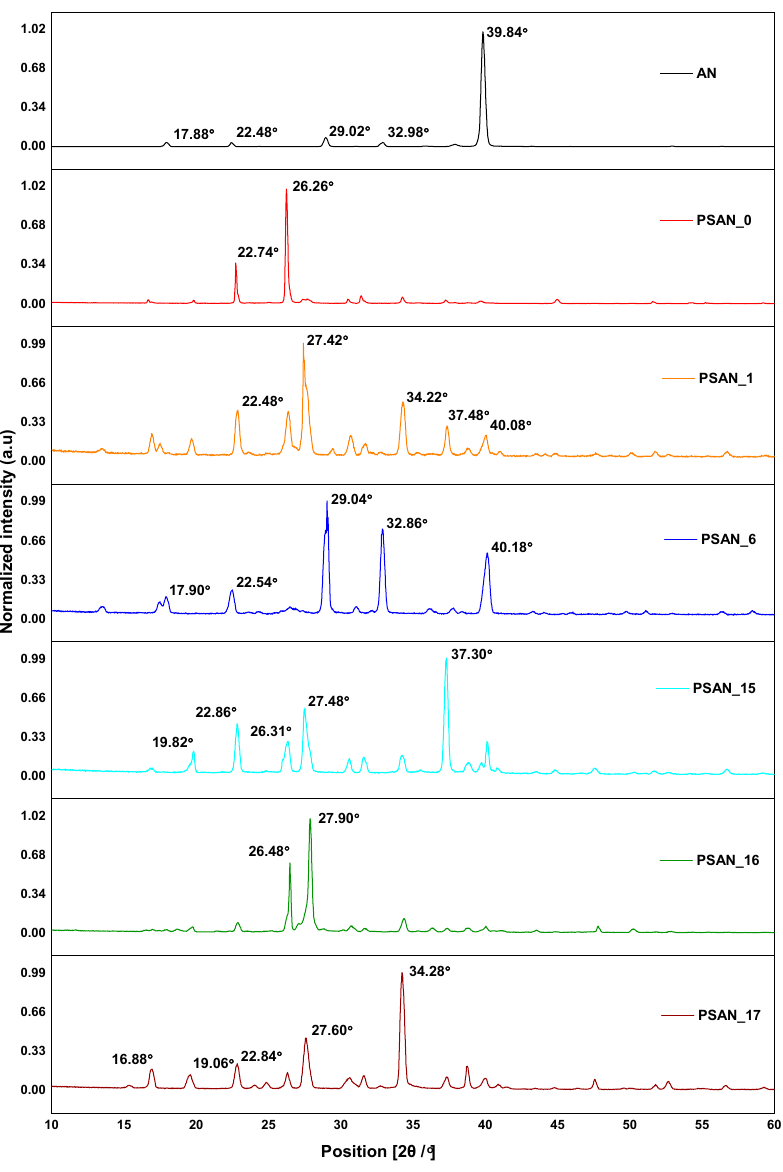
Figure 3. XRD profiles of the PSAN formulations. Table 3. Decomposition of the PSAN formulations (weight loss with temperature increase).